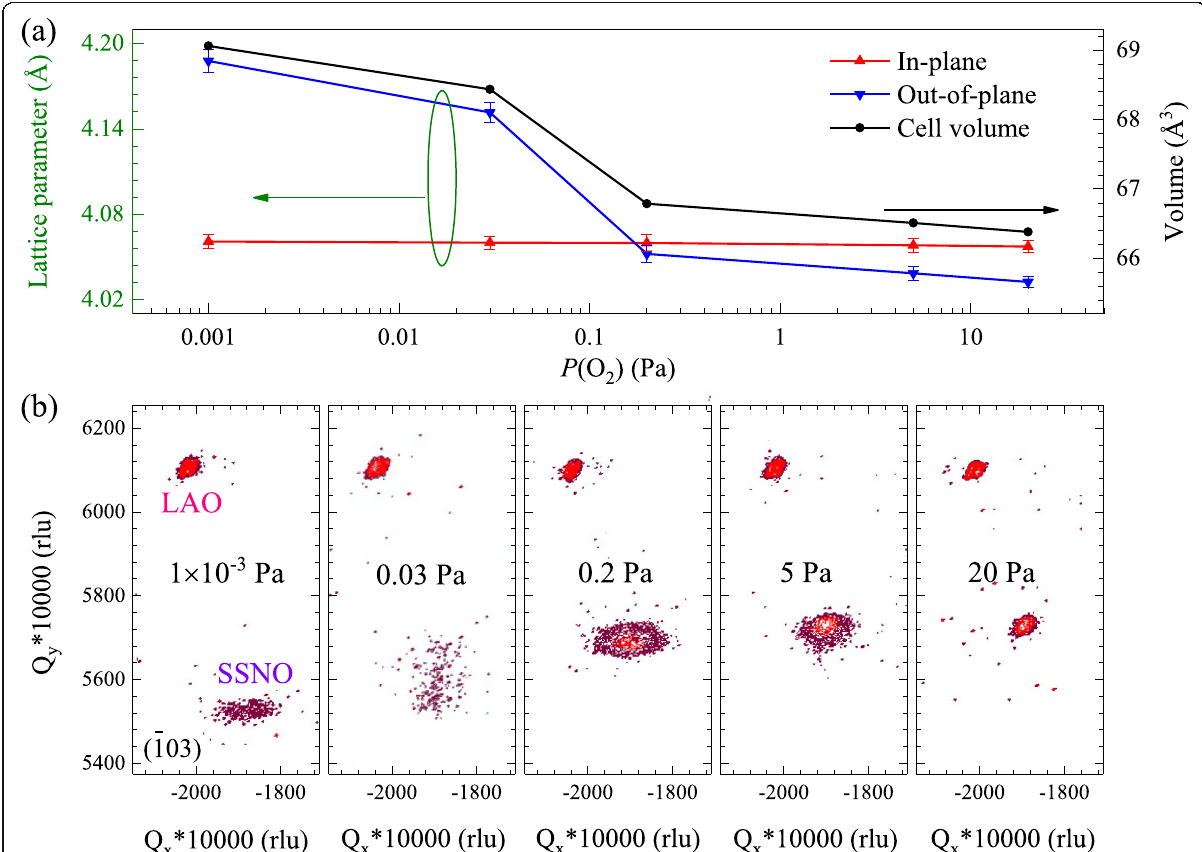
Fig. 2 a Variations of in-plane and out-of-plane lattice parameters and cell volume with increasing oxygen pressure from 1 × 10 − 3 to 20 Pa. b XRD RSMs on (1 ̅ 03) reflection collected from the SSNO/LAO heterostructures